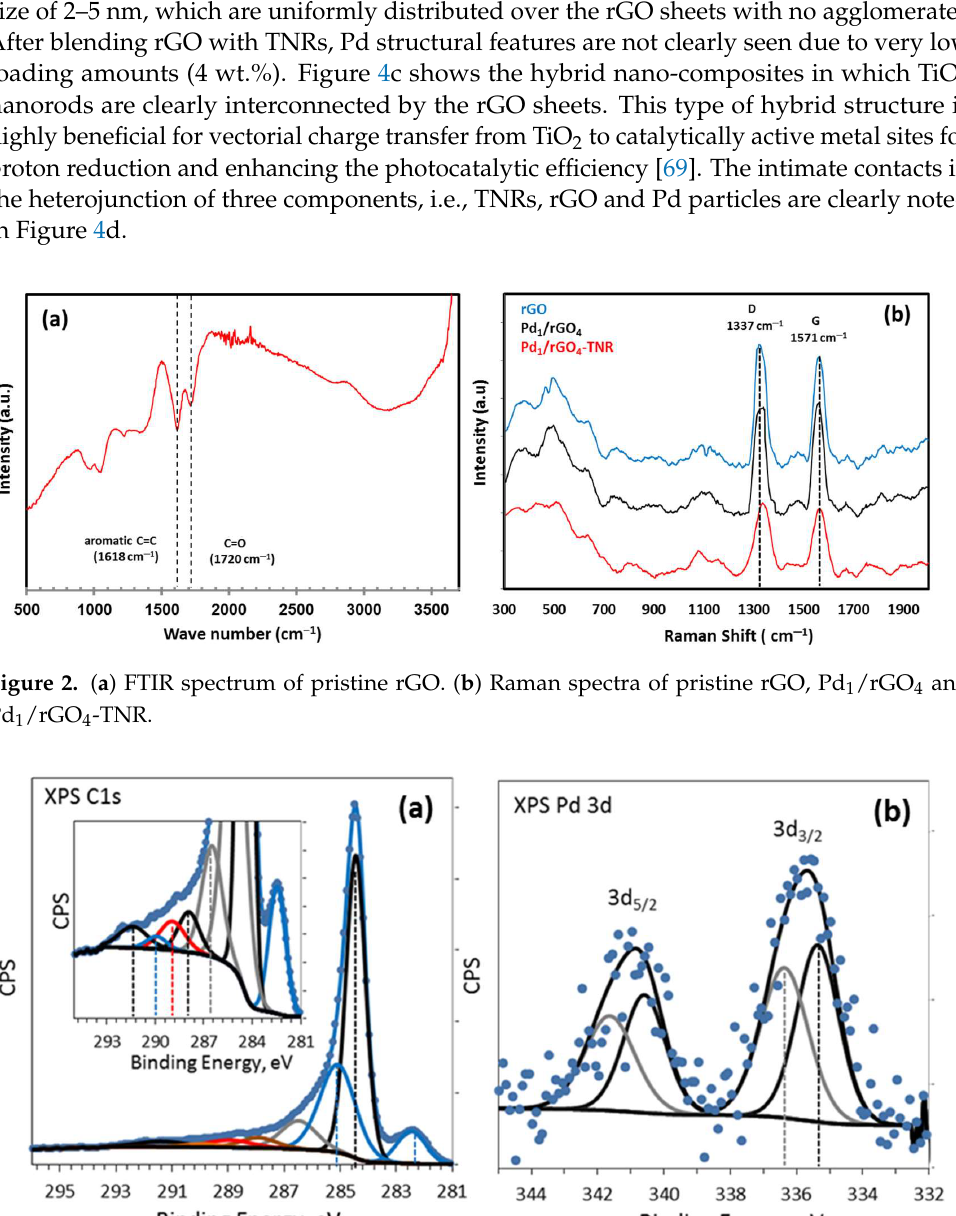
Figure 4. Transmission electron microscopy (TEM) images of pristine TNRs ( a ), Pd 1 -rGO ( b ) and Pd 1 /rGO 4 −TNR ( c , d ). To probe into the electron transfer, kinetics photoluminescence (PL) experiments were performed with as prepared materials as well as benchmark metal co-catalysts (Pt